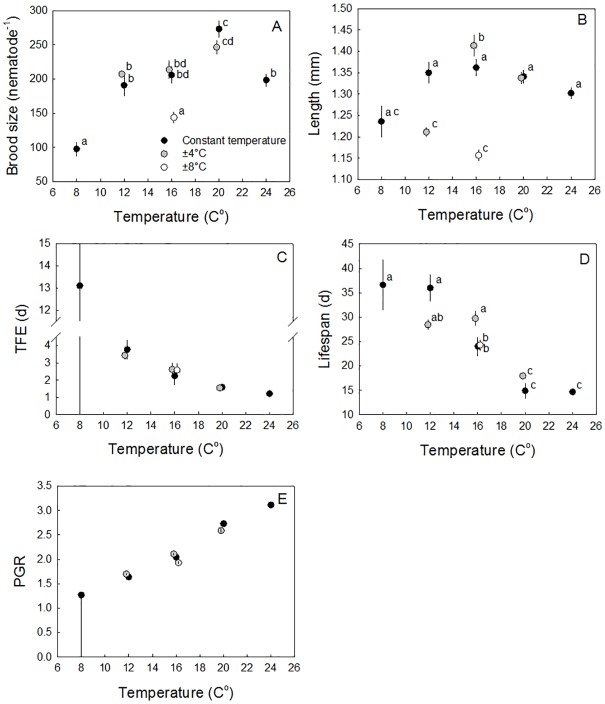
Temperature effect on five different endpoints: final brood size (A), Final body length (B), time to first egg (C), lifespan (D) and Population Growth Rate (PGR) (E).All data are given as a function of the mean temperature of the treatment. Data are given as mean ± s.e.m., apart from PGR which is given with 95% Confidence Intervals (CI) obtained by bootstrapping. Significantly different treatments (ANOVA followed by a Tukey post hoc test) are denoted by different letters. Constant temperature treatments are given in black symbols, treatments varying ± 4°C are given in grey symbols and treatments varying ± 8°C are given in open symbols.